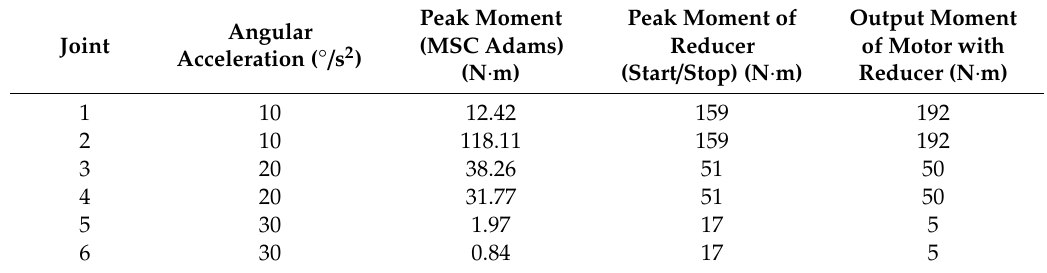
Table 4. Comparison of moments between the MSC Adams simulation of six joints and idea model.